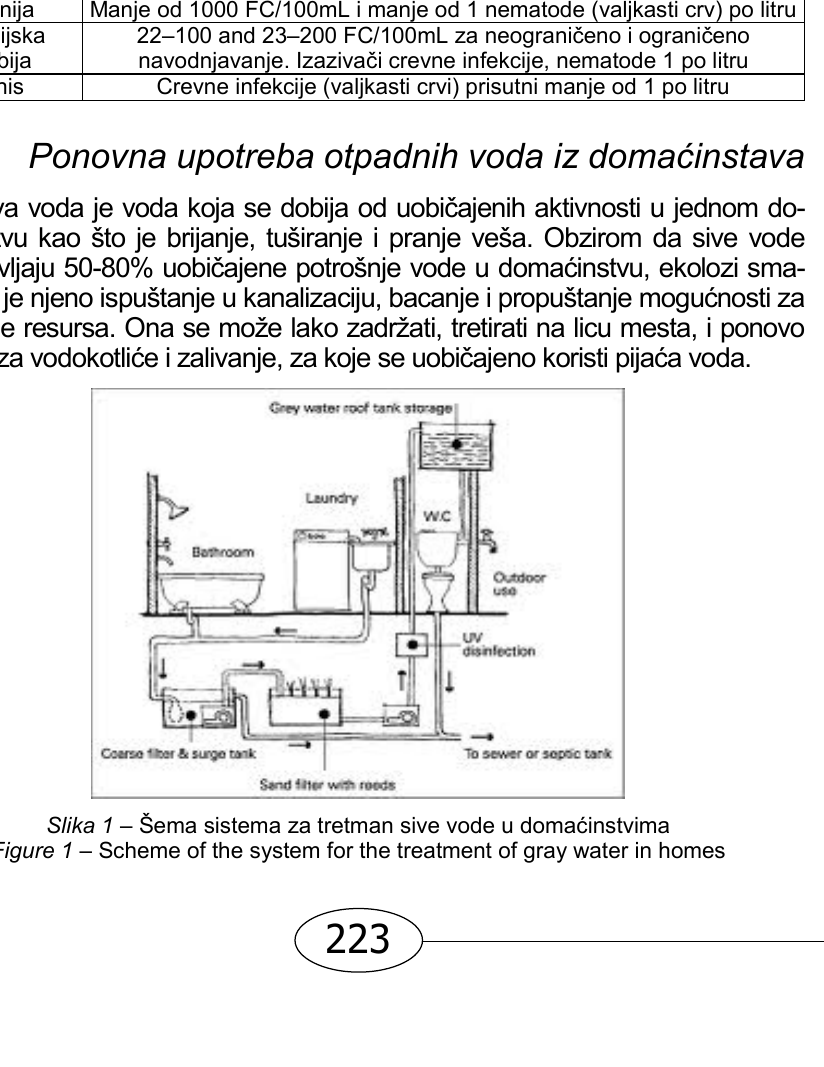
Aktuelna regulativa za ponovnu upotrebu otpadnih voda za navodnjavanje poljoprivrednih useva Current regulations for the reuse of wastewater for irrigation of agricultural crops